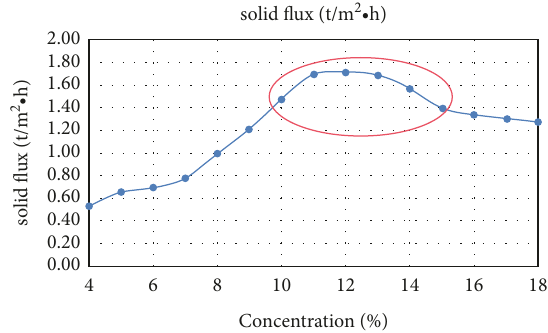
Figure 6: Solid flux-feed concentration curve.